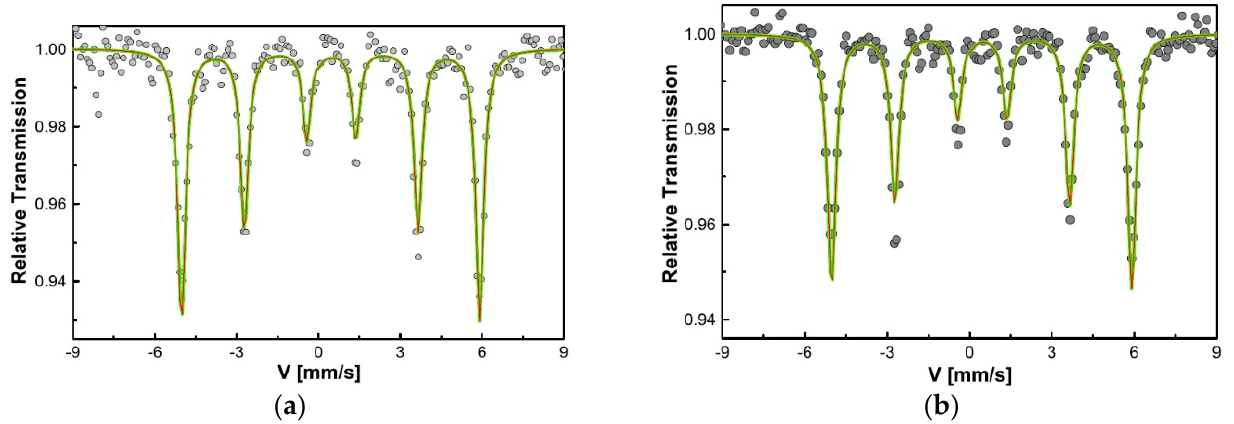
Figure 28. Room temperature Mössbauer spectra of “Gaspar” meteorite (probably, a fragment of Santa Rosa IC): side A ( a ) and side B ( b ). Adapted from [77].